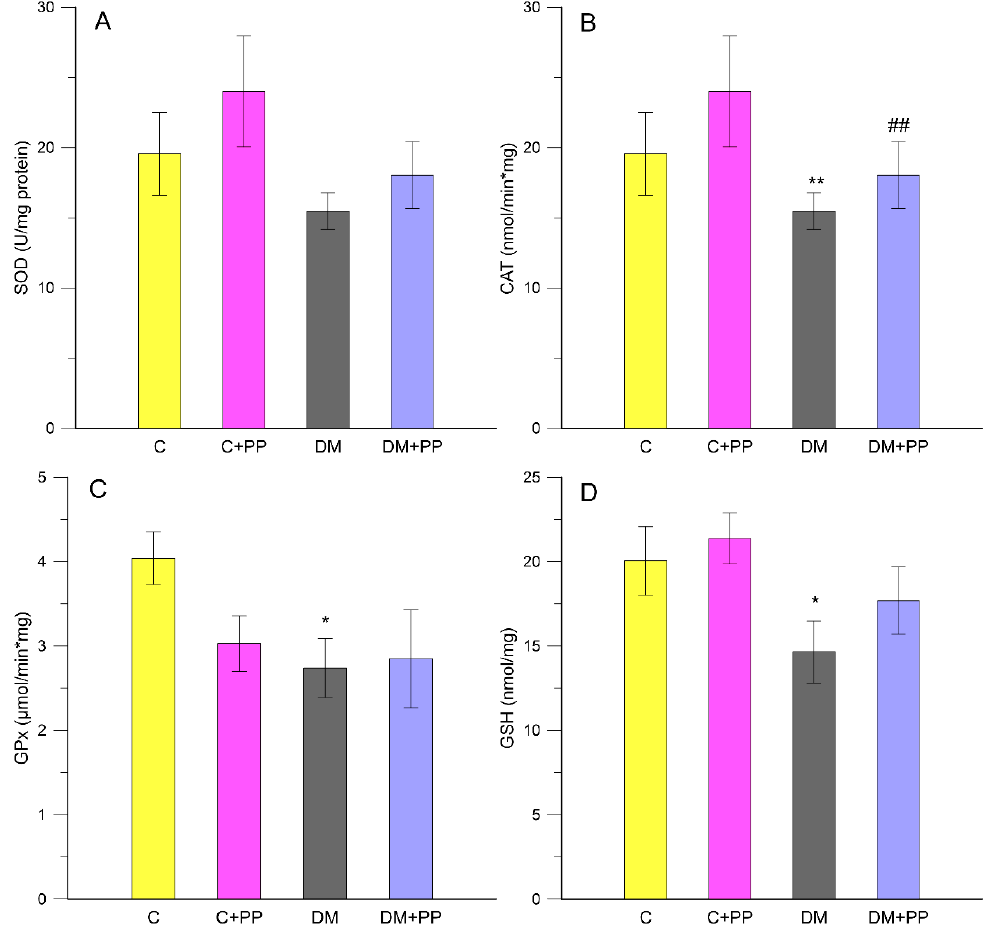
Figure 2. Effects of purple potato (PP) extract from Blue Congo (daily dose of 165 mg/kg b.w. for 14 days) on activity of antioxidant enzymes in leukocytes: ( A ) SOD, superoxide dismutase; ( B ) CAT, catalase; ( C ) GPx, glutathione peroxidase, ( D ) GSH, reduced glutathione. C—control group, C + PP—control rats receiving extract from Blue Congo, DM—diabetic group, DM + PP—diabetic rats treated with Blue Congo extract. Data are presented as means ± SD. Significance was measured using one-way analysis of variance (ANOVA). Designations: * p < 0.05, ** p < 0.01 compared to the control group; ## p < 0.01 compared to the DM